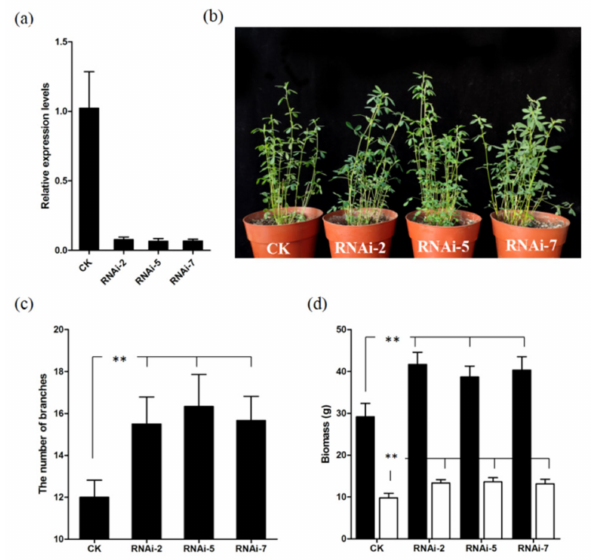
Figure 4. Phenotypic analyses of transgenic plants. ( a ) The relative expression levels of MsD14 ; ( b ) the representative phenotypes of transgenic plants; ( c ) the number of branches of transgenic plants; ( d ) the fresh and dry biomass of transgenic plants. ** indicates a significant difference at p < 0.01